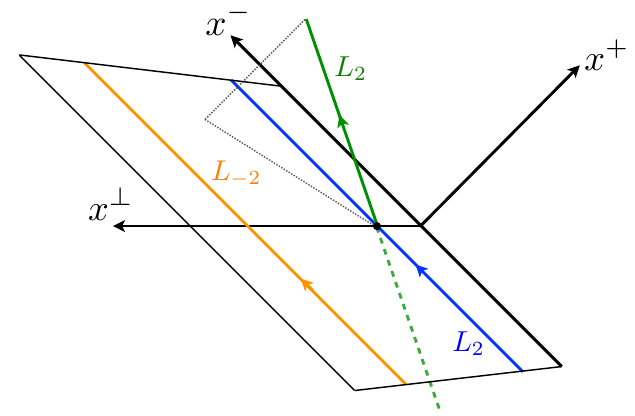
Figure 9 . The blue and orange rays represent two L − 2 operators located on the same null-plane. If we act with the S transformation on this setup, the blue ray maps to itself, while the orange ray maps to the green one. We can see that it has left the null-plane and now intersects the blue ray at an angle. Since the original blue and orange L − 2 operators commute, the configuration after the S transformation must also